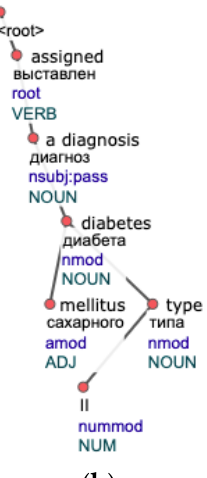
Figure 4. Tree examples of sentences where a repeat “assigned a diagnosis diabetes mellitus” will not be found by the base algorithm, as trees are checked for equality on separate iterations: ( a ) A tree with the word “assigned” as a root of height 3 is checked with trees of height 3; ( b ). A second tree with an obvious repeat is not grouped with the first one, as it has a height 4.